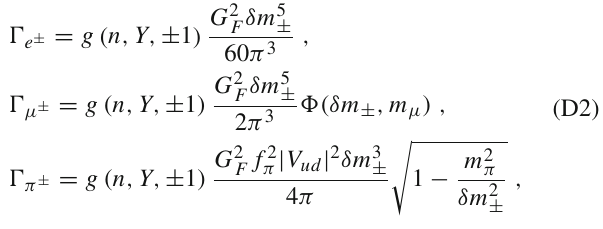
uncertainty in the theory determination of the WIMP freeze out mass in Table 1. The light green shaded region is excluded by the present experimental constraints from XENON1T [36] and PandaX-4T [5], the green dashed linesshows the expected95% CLreach ofLZ/XENONnT [8,9] and DARWIN